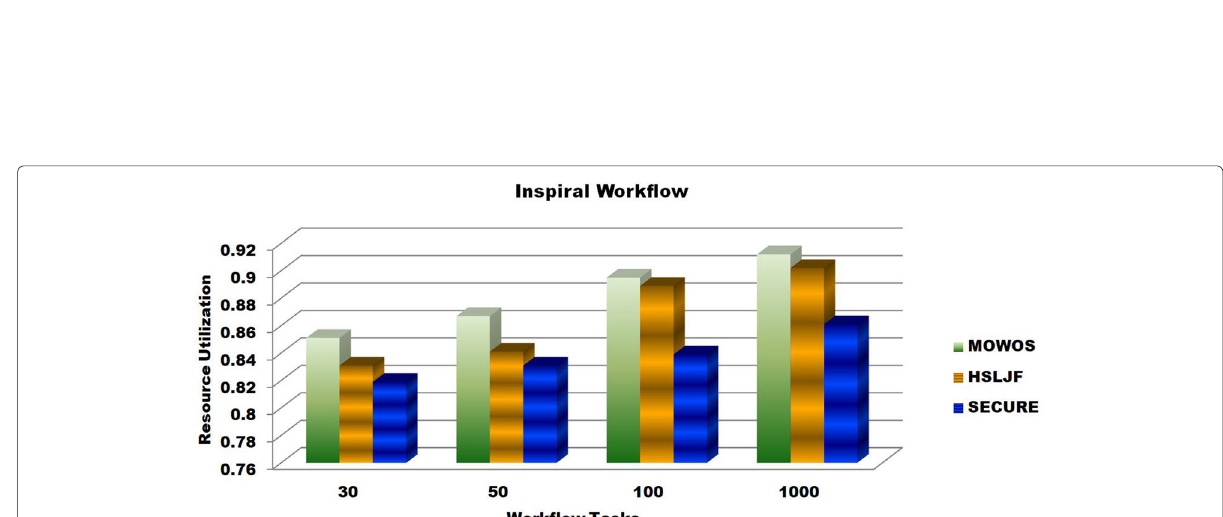
Fig. 16 Comparison of resource utilization using inspiral